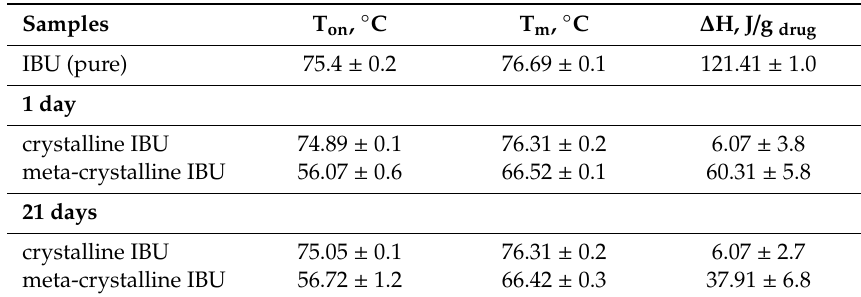
Table A1. Summary of DSC analysis of 20% w / w IBU-CLAD mixtures following storage at 75% RH and room